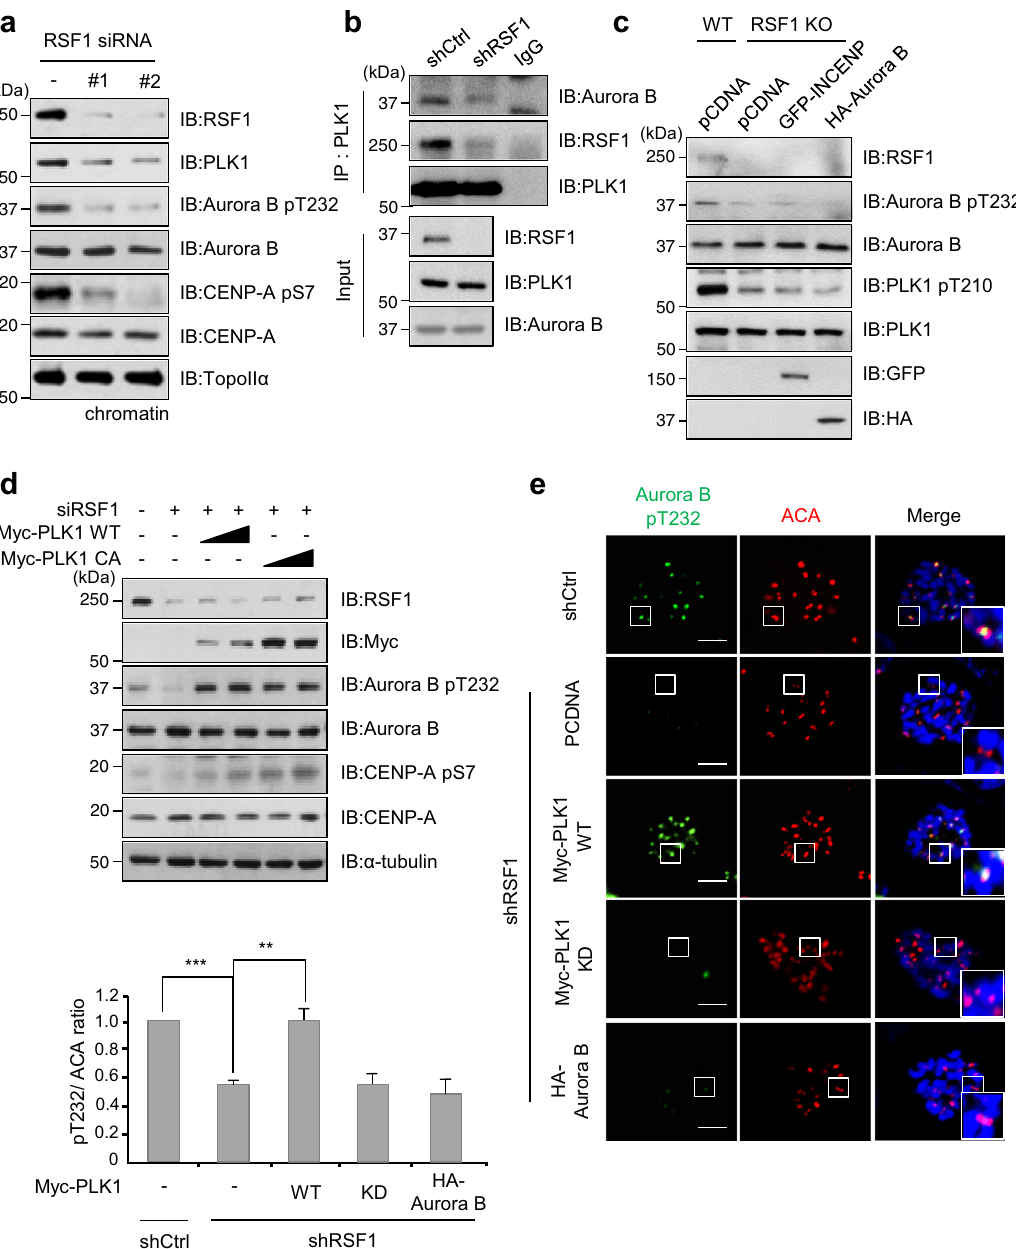
Fig. 2 RSF1-dependent PLK1 deposition is required for the Aurora B kinase activity. a The HeLa cell lysates were obtained from mitotic shake-off after treatment with nocodazole for 16 h in RSF1 siRNA-expressing cells. Western blot analysis of chromatin fraction was immunoblotted for indicated antibodies. TopoII- α was used as a marker for chromatin fraction. b Control or RSF1 shRNA mitotic cell lysates were immunoprecipitated with anti-PLK1 antibody and immunoblotted with indicated antibodies. c GFP-INCENP or HA-Aurora B plasmid was transfected into RSF1 KO cells and treated with nocodazole for 16 h. Mitotic cell lysates were subjected to immunoblot analysis with indicated antibodies. d Exogenously transfected with Myc-Plk1 WT or CA into RSF1-depleted HeLa cells and mitotic cells were obtained with nocodazole treatment for 16 h. The lysates were processed for immunoblotting analysis using indicated antibodies. e Myc-PLK1 WT, KD, or HA-Aurora B expression vectors were introduced into HeLa cells, stably expressing RSF1 shRNA, and then mitotic cells were obtained with nocodazole treatment. The mitotic cells were stained with anti-pAurora B T232 (green) and ACA (red) antibodies, and DAPI was used to stain the nuclei (blue). The graph represents mean ± SEM from three independent experiments; shCtrl n = 28, shRSF1 n = 34, shRSF1 + PLK1 WT n = 37, shRSF1 + PLK1 KD n = 29, and shRSF1 + HA-Aurora B n = 24 cells. ** p < 0.005 vs. control shRNA, *** p < 0.001 vs. p cDNA in shRSF1 by two-sided unpaired Student ’ s t -test. Scale bar, 5 μ m. Data of a , c , d are representative of three independent experiments. Data of b are representative of two independent experiments. Source data are provided as a Source Data fi